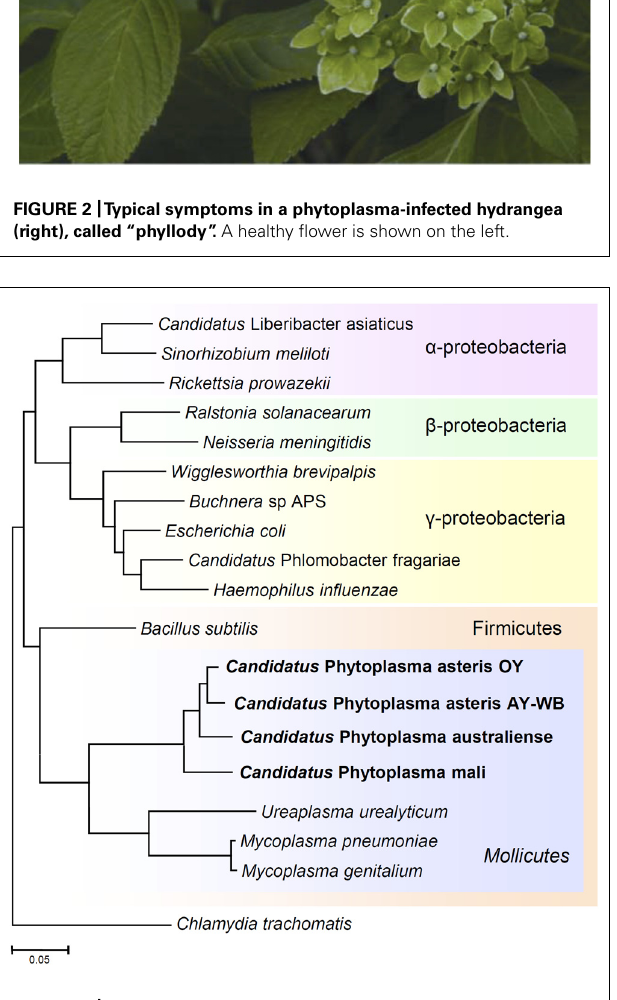
FIGURE 3 | Phylogenetic distance tree constructed by the neighbor-joining method, comparing the 16S rRNA gene sequences of phytoplasmas with those of other bacteria obtained from GenBank. The sequence of Chlamydia trachomatis was used as an out-group to root the tree. Phytoplasmas are currently classified as Mollicutes, along with mycoplasmas.